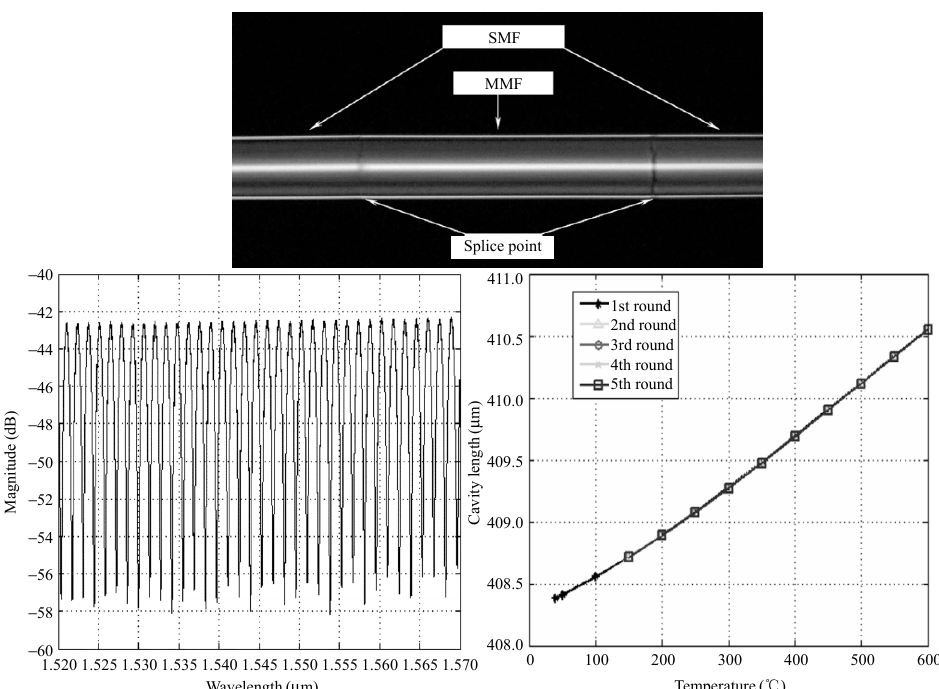
Fig. 13 Picture of SMS IFPI sensor and its spectra and temperature response [105].